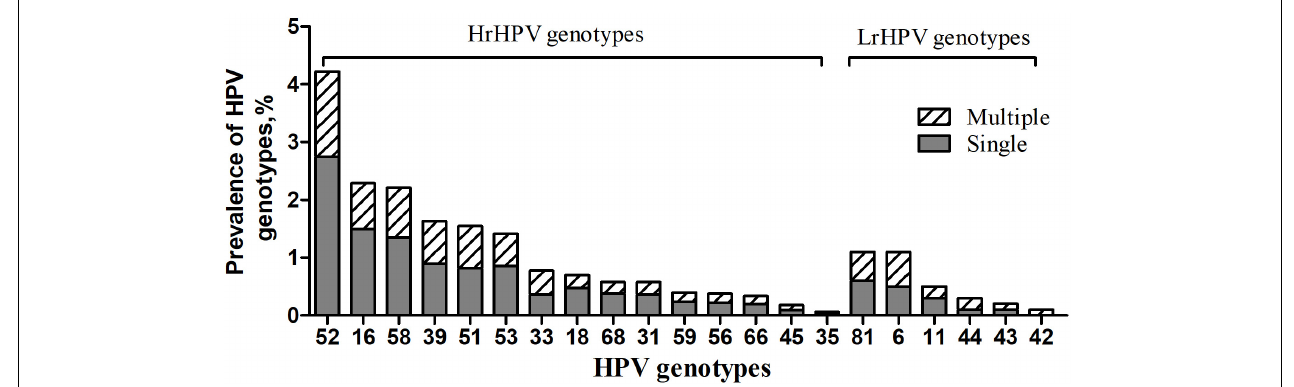
FIGURE 1 | Prevalence of HrHPV and LrHPV genotypes in single and multiple HPV infections. The most common HrHPV genotype detected was HPV 52(4.2%), followed by HPV 16(2.3%), HPV 58(2.2%), HPV 39(1.6%), HPV 51(1.6%), HPV 53(1.4%), HPV 33(0.8%), HPV 18(0.7%), HPV 68(0.6%), HPV 31(0.6%), HPV